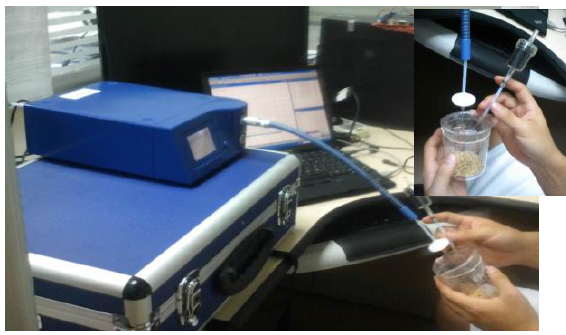
Figure 3. Sampling set-up using the electronic nose.